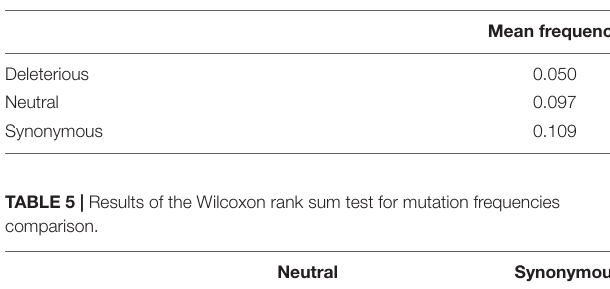
TABLE 4 | Mean ffrequencies of non-synonymous deleterious and neutral mutations, as well as synonymous mutations in chickpea dataset.